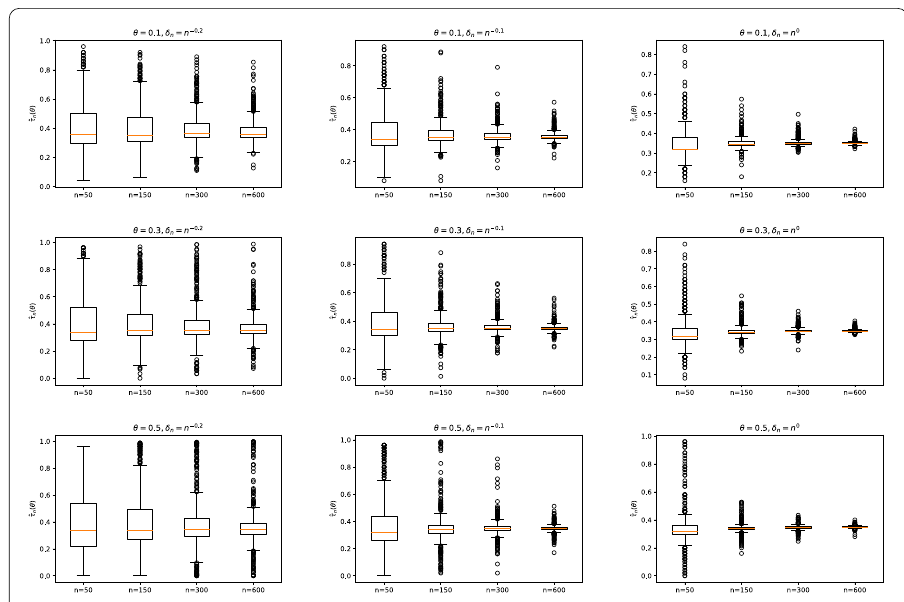
Figure 1 Boxplots of ˆ τ n ( θ ) with different values of parameters θ and δ n in the case τ 0 = 0.35